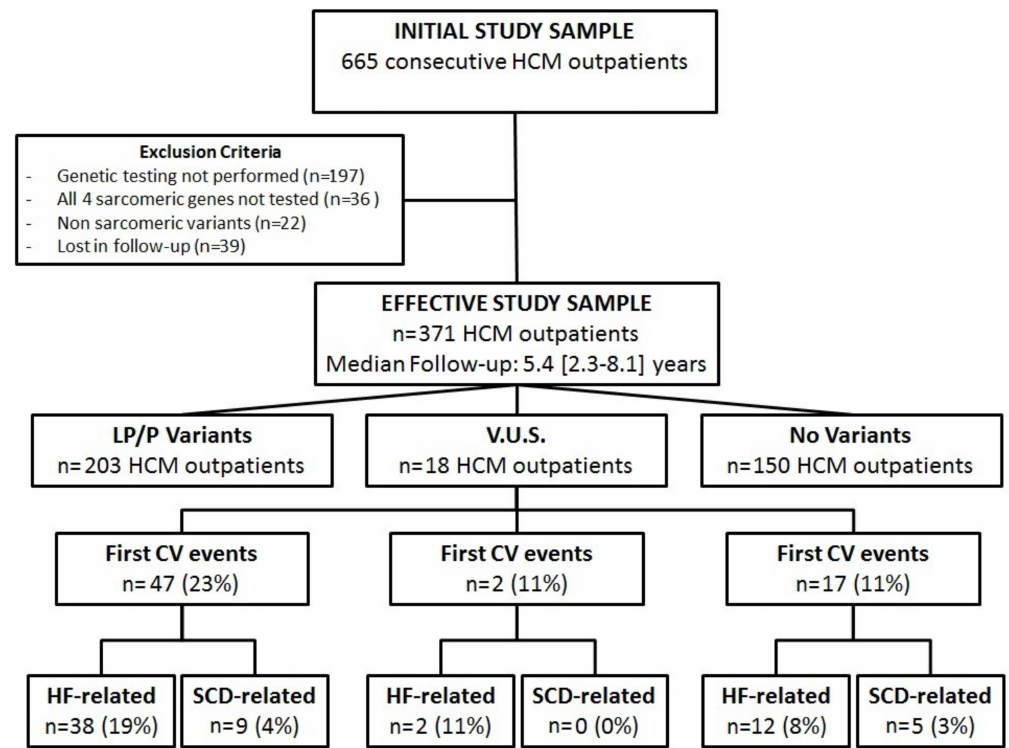
Figure 1. Diagram showing the step-by-step classification of the hypertrophic cardiomyopathy (HCM) population considered in our study. LP / P: likely pathogenic / pathogenic sarcomeric variants; V.U.S.: variant of uncertain significance; CV: cardiac events; HF: heart failure; SCD: sudden cardiac